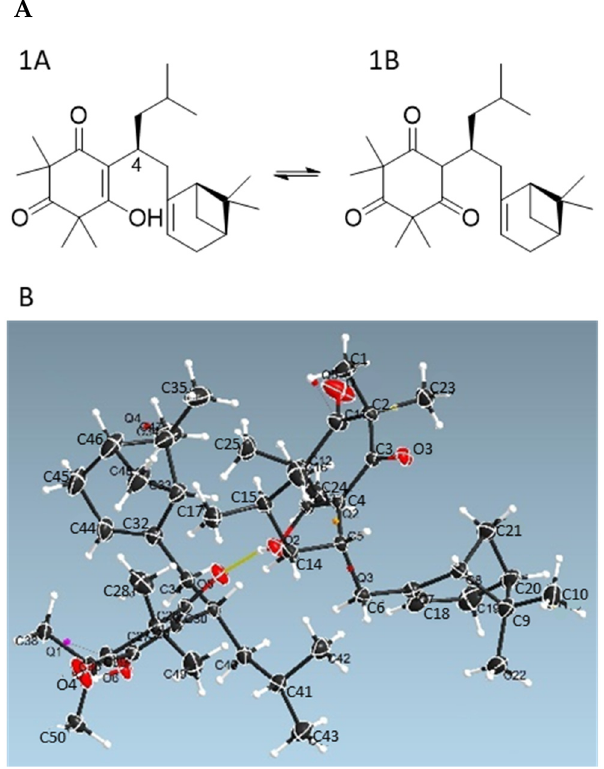
Figure 2. ( A ) Two tautomeric forms 1A and 1B of 1 . ( B ) Oak Ridge Thermal Ellipsoid Plot (ORTEP) drawing of 1A.